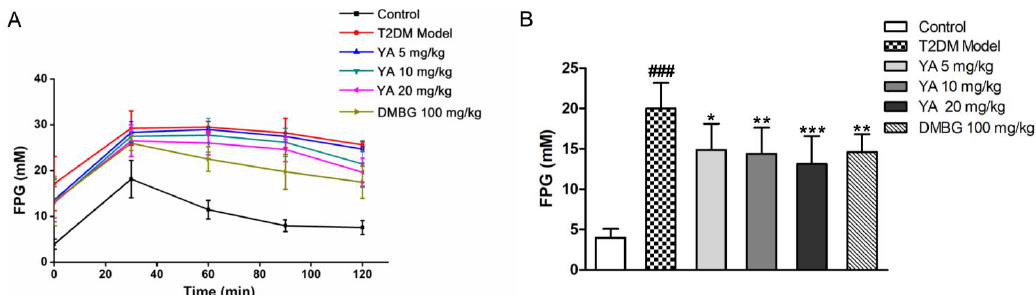
Figure 7. Effect of YA on FPG in different groups. ( A ) FPG of different groups at different time points; ( B ) FPG of different groups at 120 min. Data are expressed as mean ± SD for each group. ( n = 8; DMBG: metformin) (### p < 0.001 vs. control, * p < 0.05 vs. T2DM model, ** p < 0.01 vs. T2DM model, *** p < 0.001 vs. T2DM model).